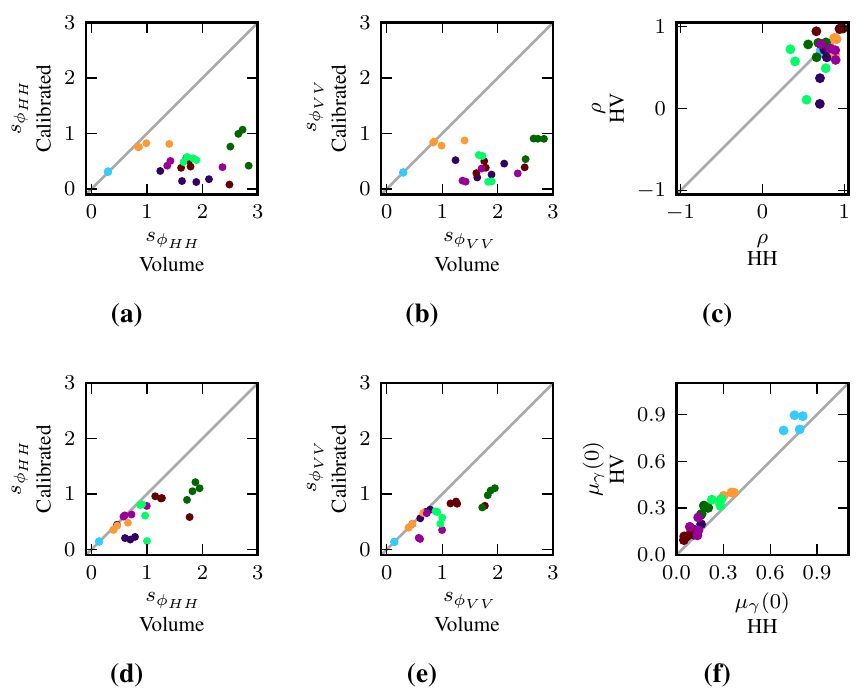
Figure 7. The first two columns contain scatter plots of the phase correlation and misfit for HH and VV between volume-only and calibrated versions of the model. The third column shows a comparison between HV and HH fit using the Hallikainen mixing model. The colours of the symbols represent the agricultural fields as in Figure 6. ( a ) Phase slope HH: Peplinski model; ( b ) Phase slope VV: Peplinski model; ( c ) Correlation φ : HH and HV (volume-only); ( d ) Phase slope HH: Hallikainen model; ( e ) Phase slope VV: Hallikainen model; ( f ) Misfit φ : HH and HV